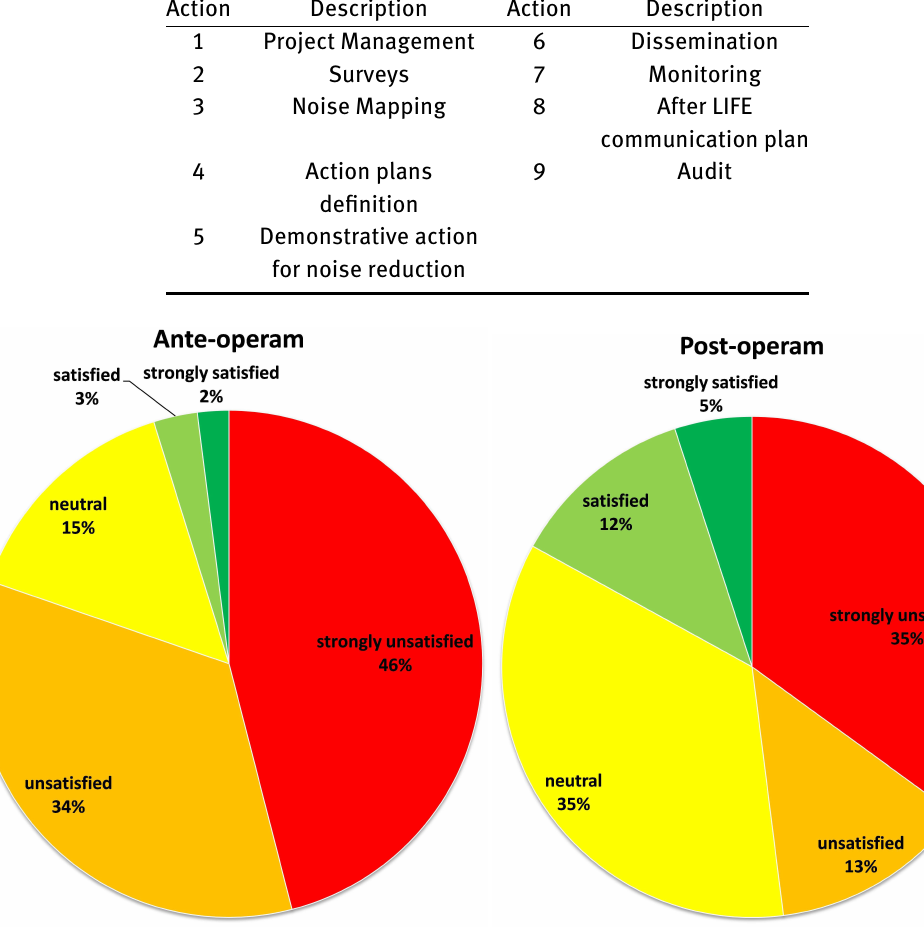
sues due to their managed sources a common guideline